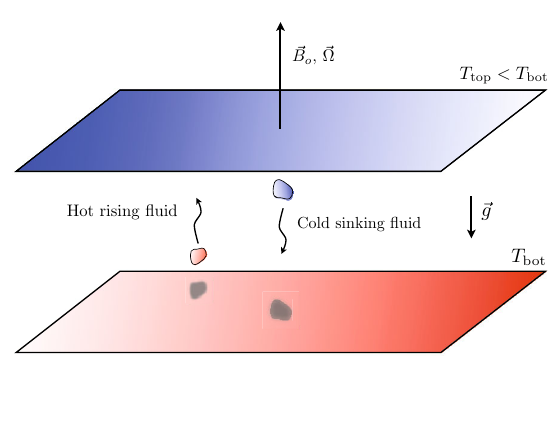
Fig. 8 The rotating MHD Rayleigh–Bénard convection problem